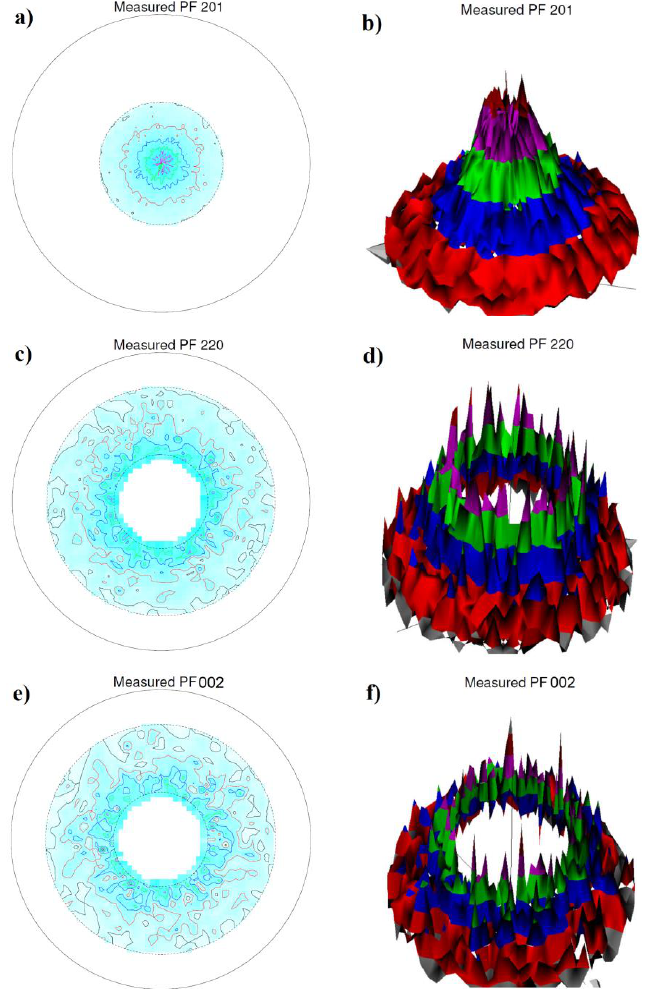
Figure 5. Pole figures and 3-D contours for a Bi 2 O 3 film with tetragonal crystal system (β-phase; P-421c):